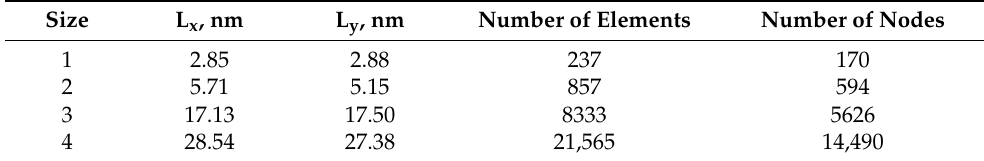
Table 3. Geometry of the studied single-layer InN nanosheets.